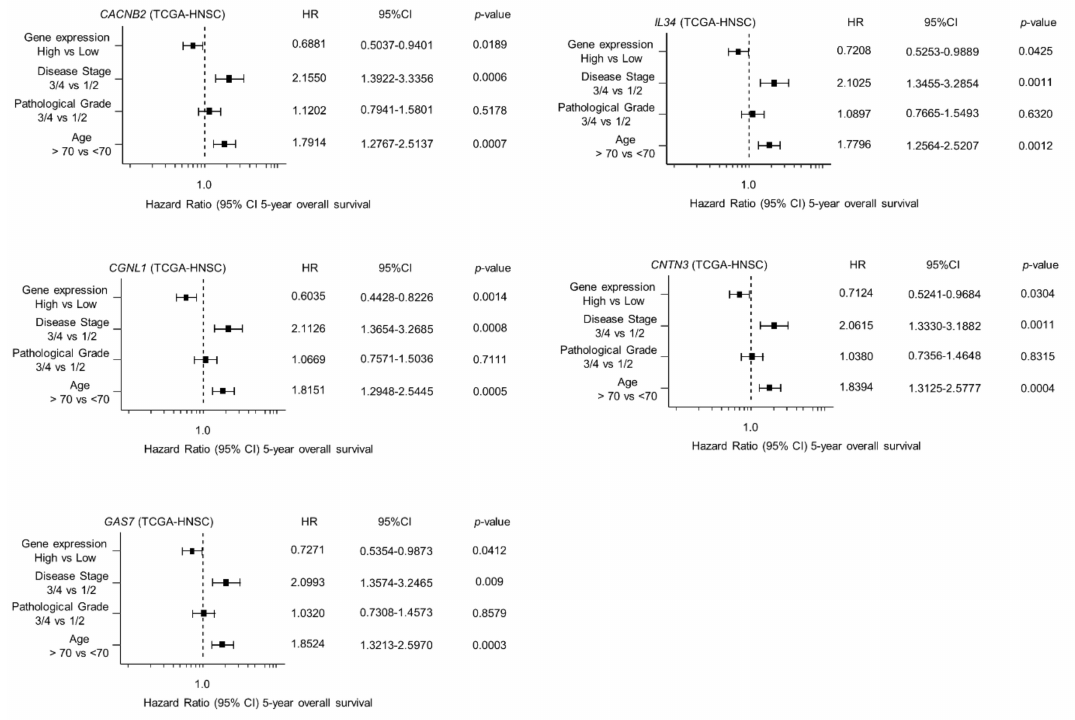
Figure 6. Forest plot showing the multivariate analysis results for the five target genes ( CACNB2, IL34, CGNL1, CNTN3 , and GAS7 ) identified by analysis of TCGA-HNSC data. The multivariate analysis determined that the expression levels of five genes were independent prognostic factors in terms of the 5-year overall survival rate after the adjustment for tumor stage, age, and pathological stage ( p < 0.05).